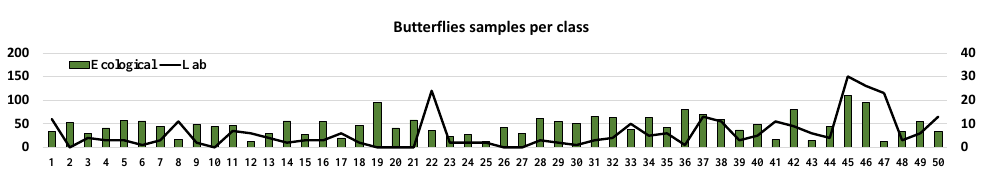
Figure 3. Representative images of butterfly species. The text above the images shows the species. The images can be better seen on a monitor when zoomed in.